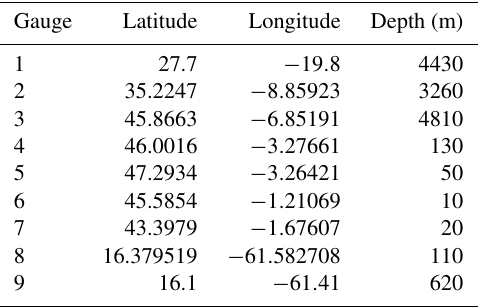
Table 1. Summary of locations of numerical output (see Fig. 4 for gauges 1, 2 and 3, Fig. 5 for gauges 4, 5, 6 and 7, and Fig. 6 for gauges 8 and 9).